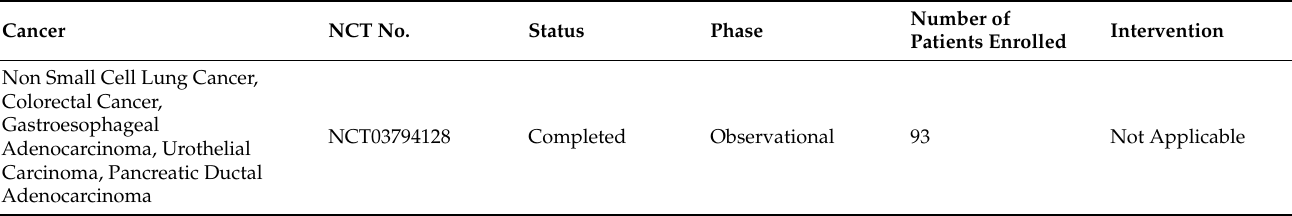
Table 1. Clinical Trials Identifying